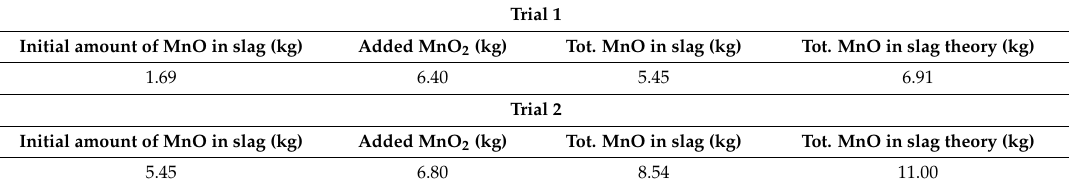
Table 7. The initial amount of MnO, the added amount of MnO 2 , the total amount of MnO, and theoretical amount of MnO in the slag for the two trials